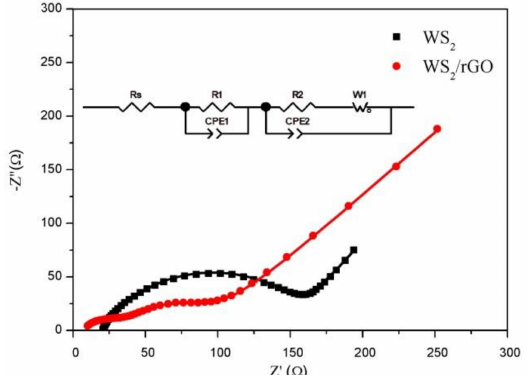
Figure 5. The Nyquist plots of bare WS 2 and WS 2 /rGO composite range from 10 5 Hz to 10 − 2 Hz after 100